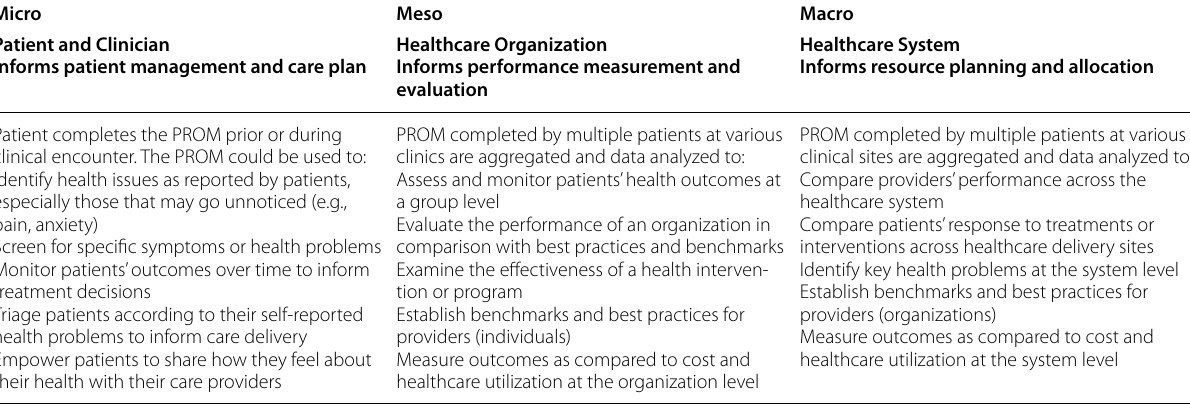
Table 2 Key usages of PROMs data at the micro, meso, and macro levels within the system Micro Meso Macro Healthcare Organization Informs performance measurement